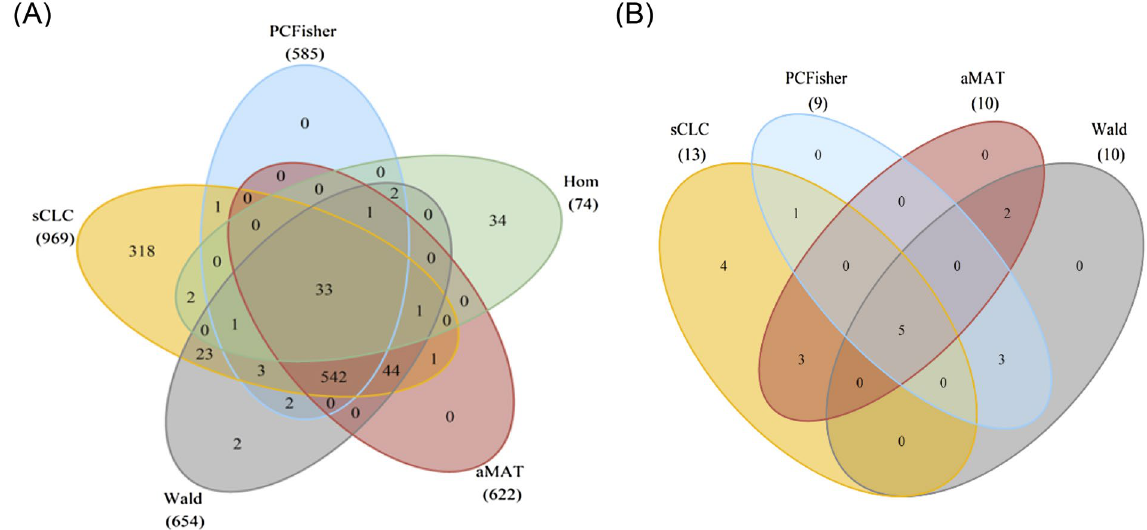
Figure 2. Venn diagram. ( A ) The number of significant SNPs identified by the five methods. ( B ) The number of lead SNPs identified by sCLC, Wald, aMAT, and PCFisher.